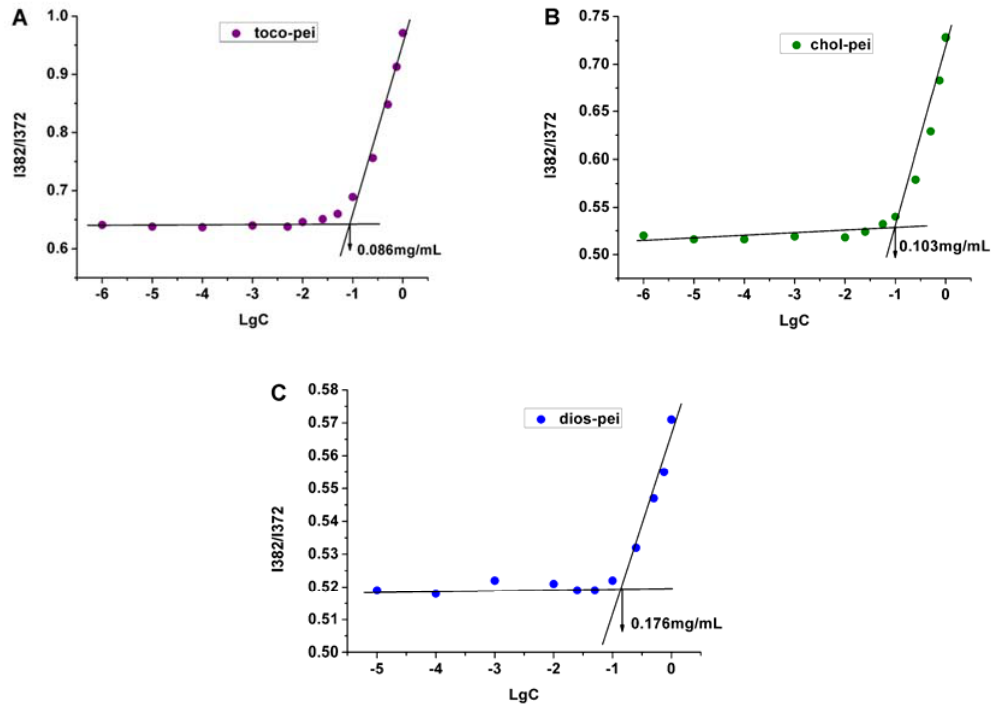
Figure 2. Plots of intensity ( I 383 / I 373 ) ratios from the emission spectra of pyrene versus the logarithm